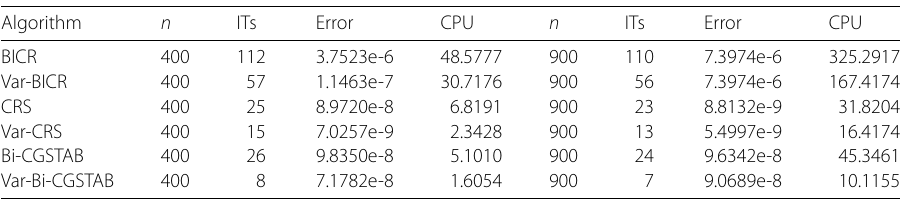
Table 3 Numerical results for Example 4.2